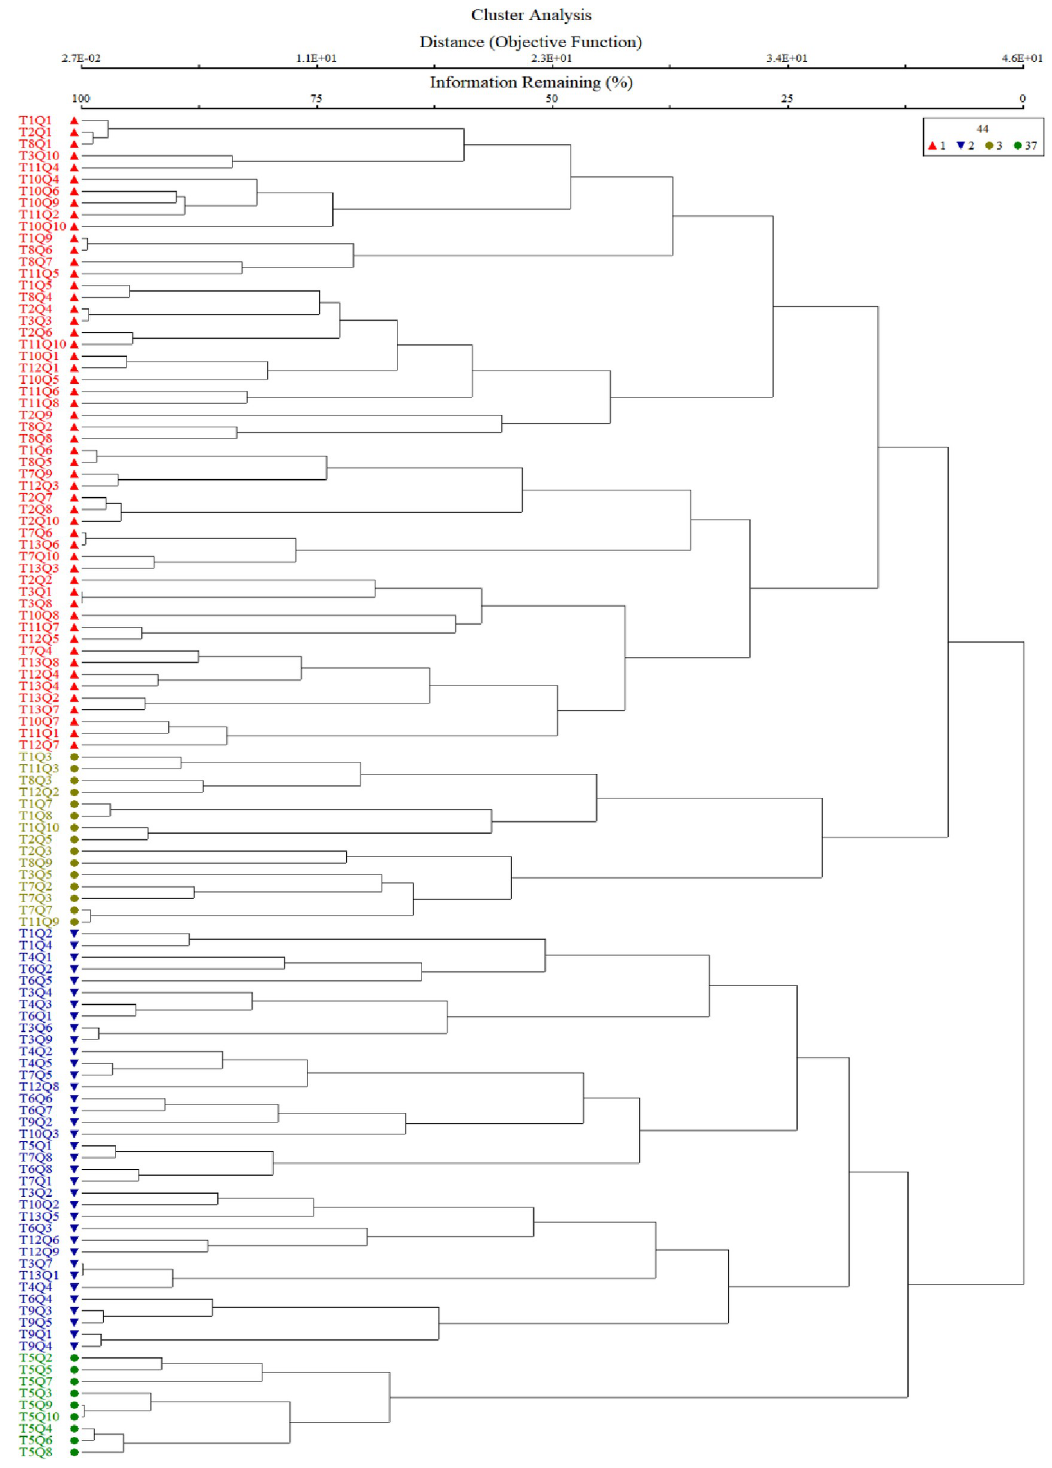
Fig 2. Cluster dendrogram showing communities classification based on Sorenson Distance Measurements and Ward Linkage Method of the region.